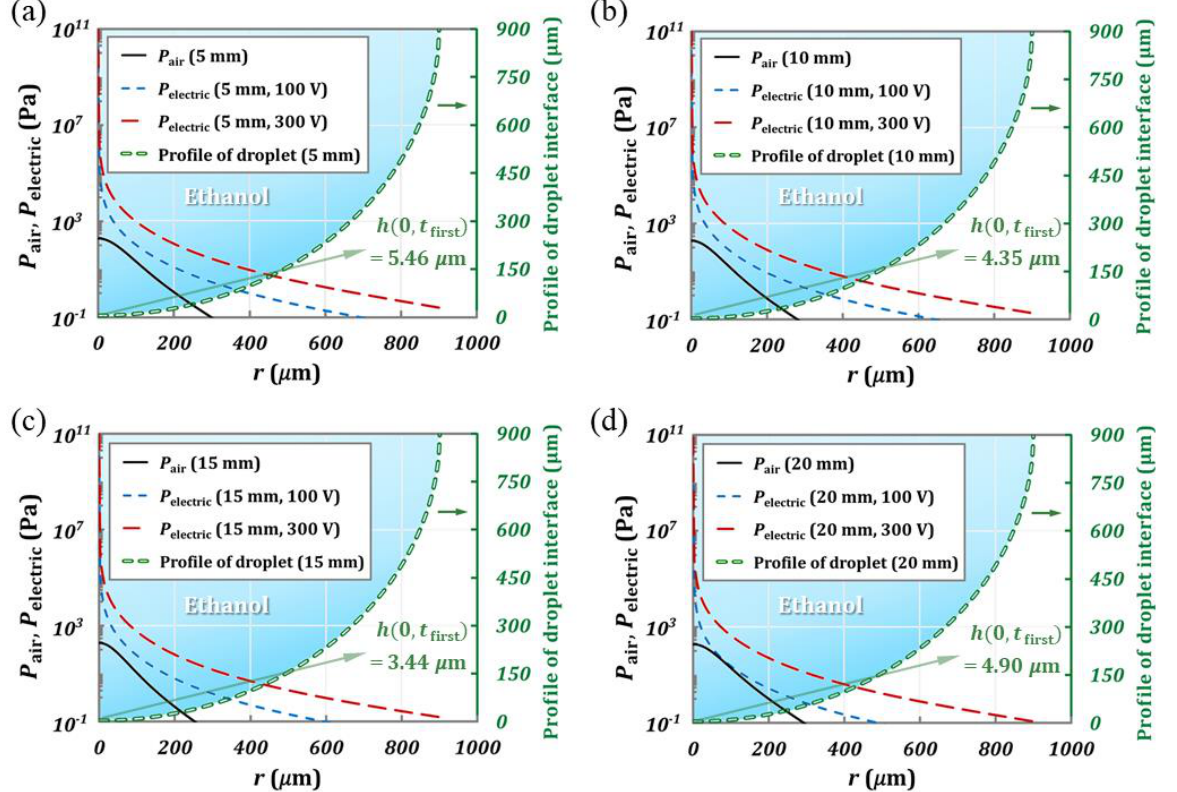
Figure 8. Comparison between electric pressure and the air pressure for an electrified ethanol droplet. ( a – d ), Electric pressure and air pressure along the radial direction for electrified ethanol droplet with various applied voltages and 4 Weber numbers ( 𝑊𝑒 = 4.21, 10.41, 17.50, 24.27).